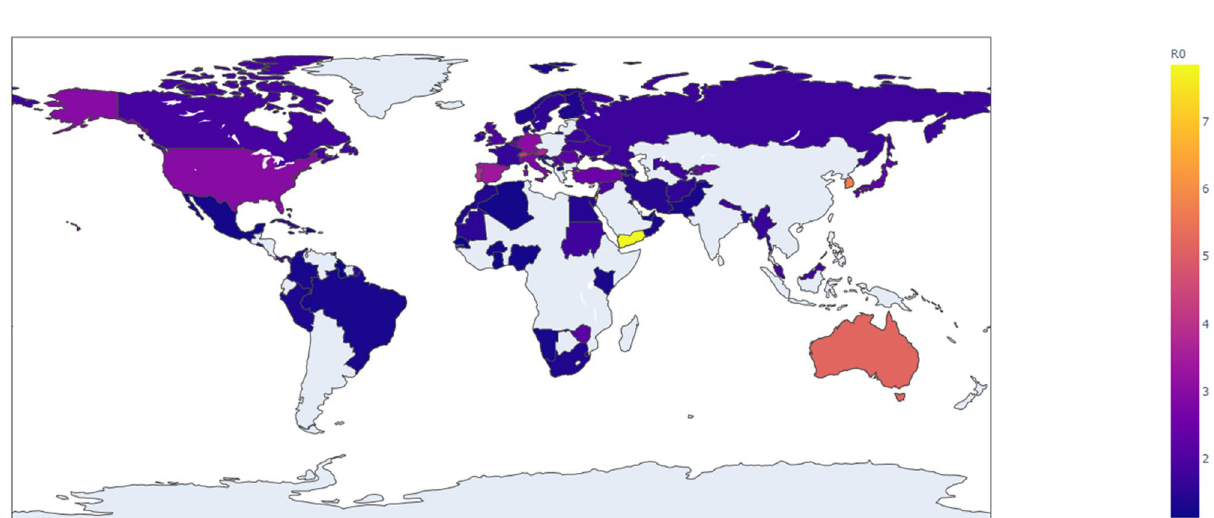
Figure 2. The basic reproduction number of COVID-19 across